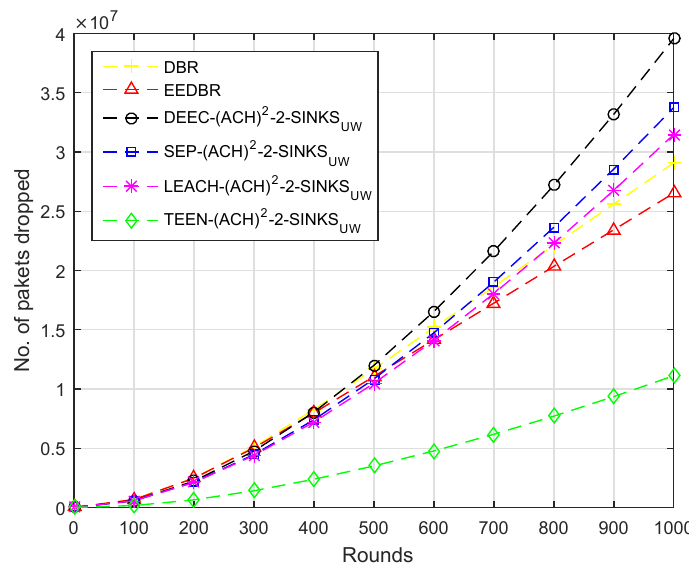
Figure 16. Number of Packets Dropped.